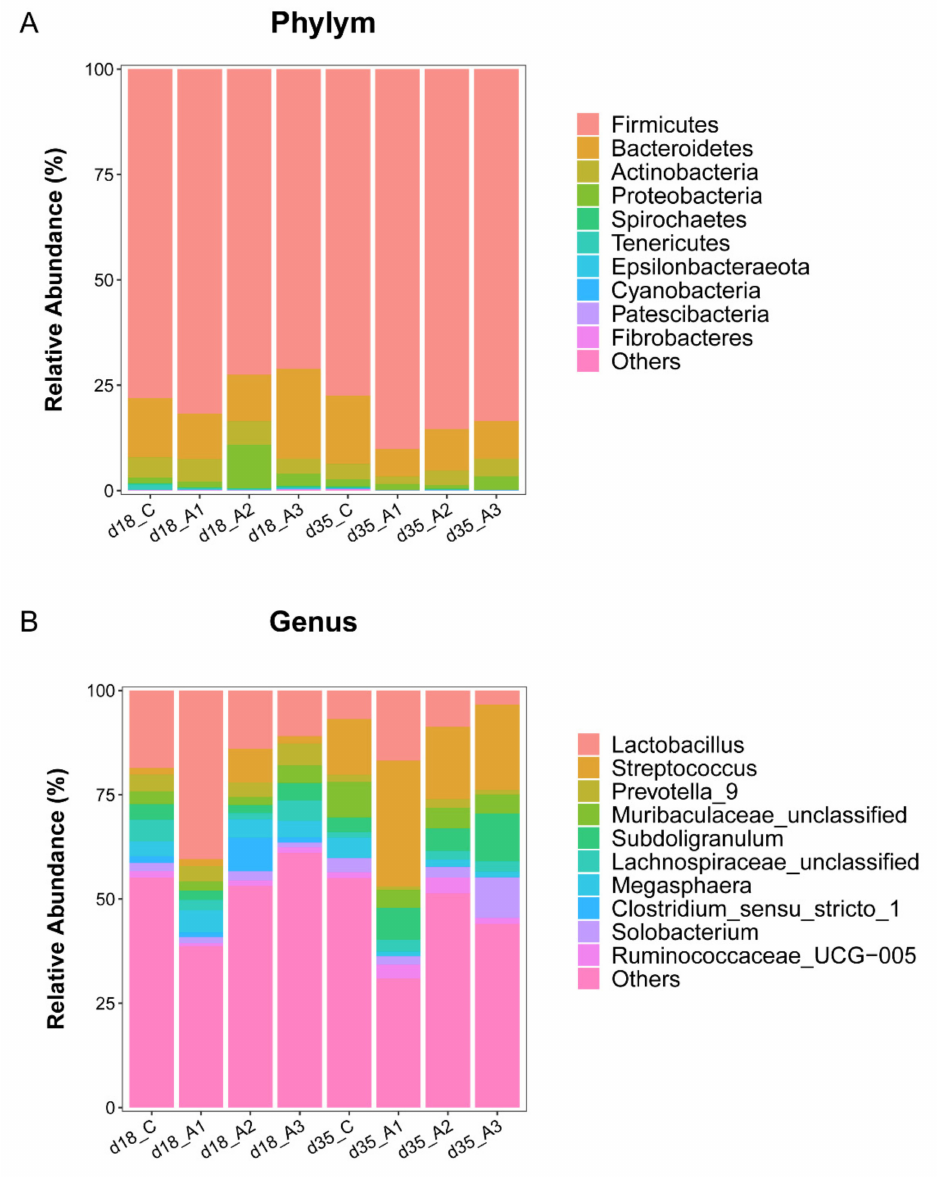
Figure 2. Gut microbiota composition of experimental group pigs and control group pigs: The relative abundance of the top 10 intestinal flora at the phylum level ( A ); the relative abundance of the top 10 intestinal flora at the genus level ( B